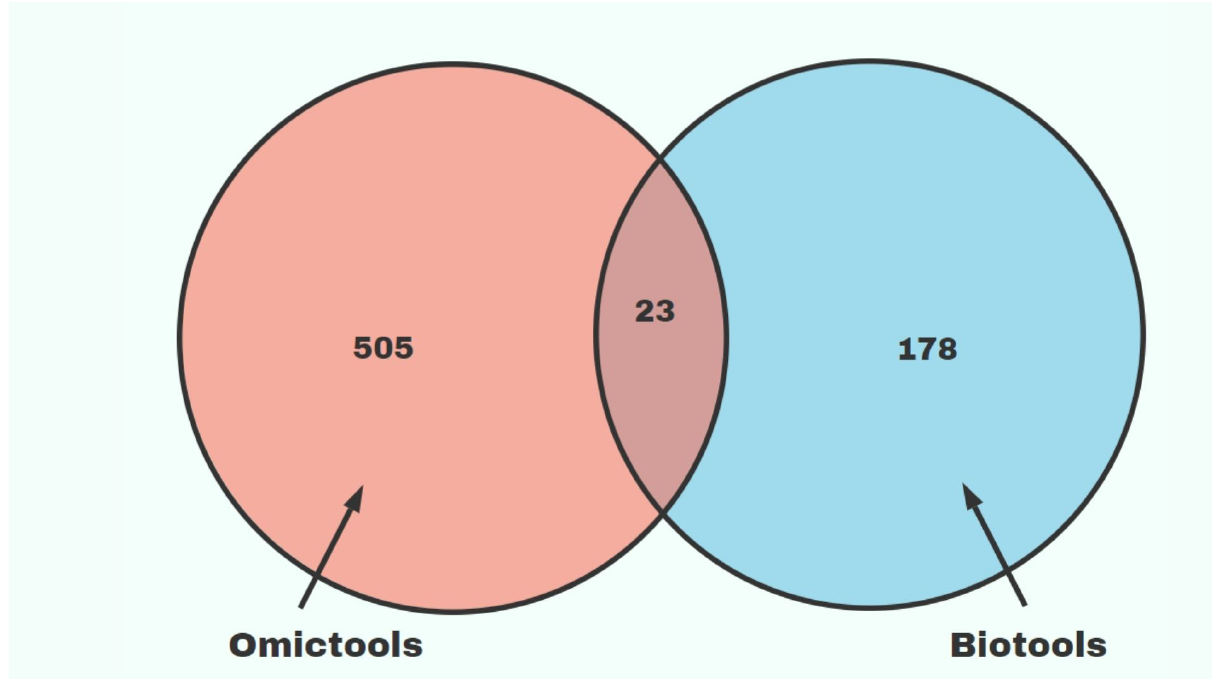
Figure 4 – Venn diagram of the resources used for the review of